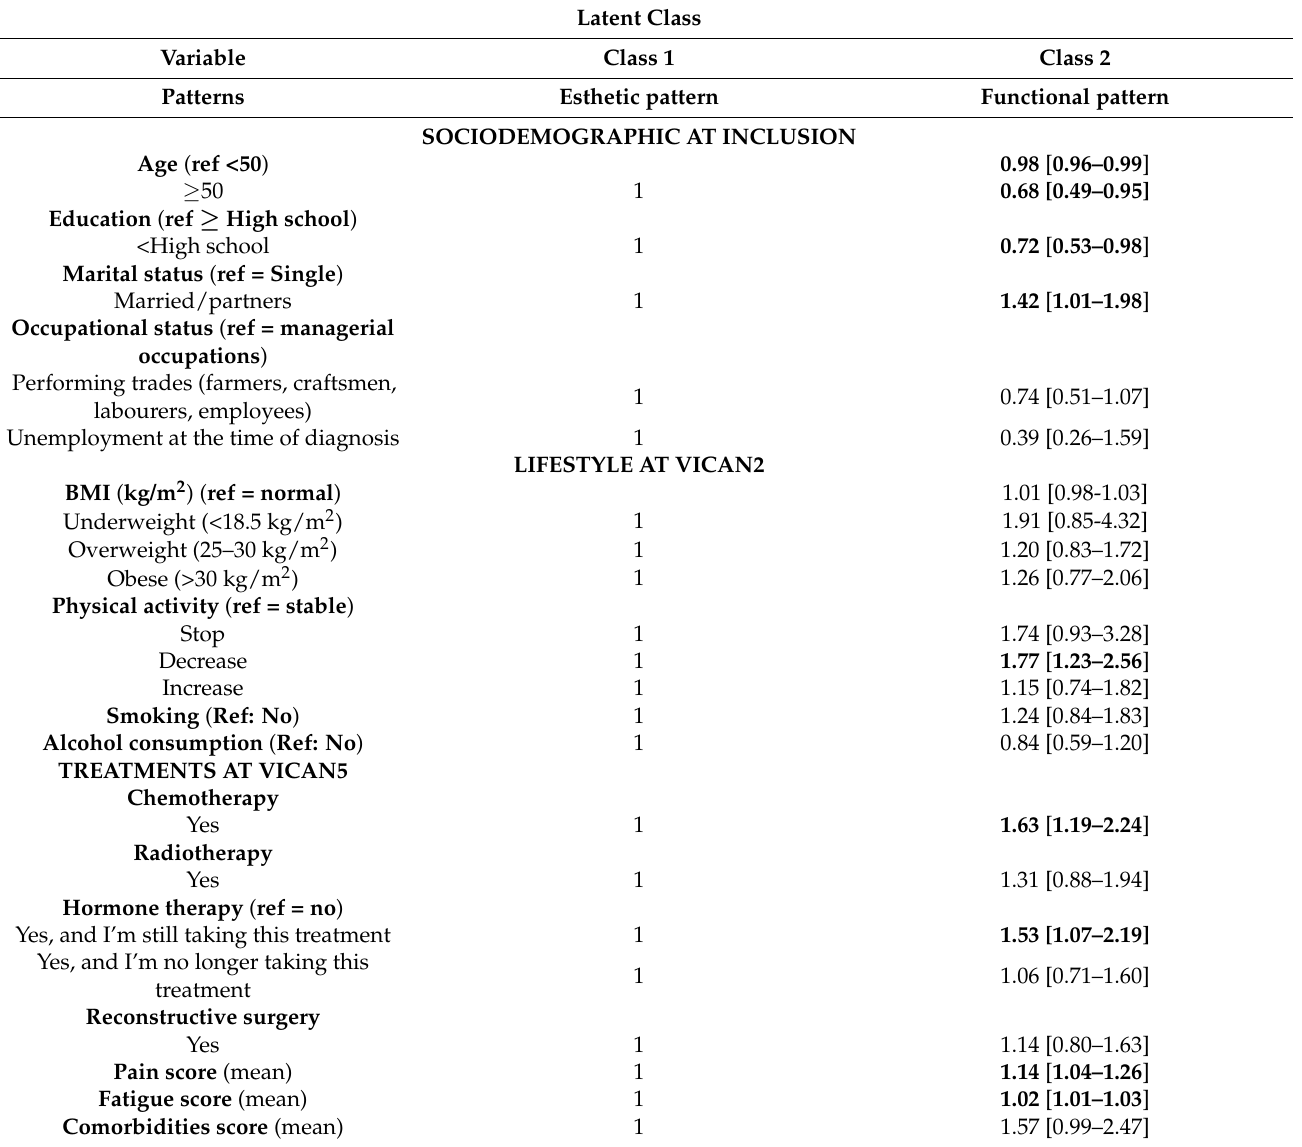
Table 4. Univariate logistic regression odds ratios of potential risk factors for latent class membership (compared to esthetic pattern) of BC women from the VICAN study ( n =